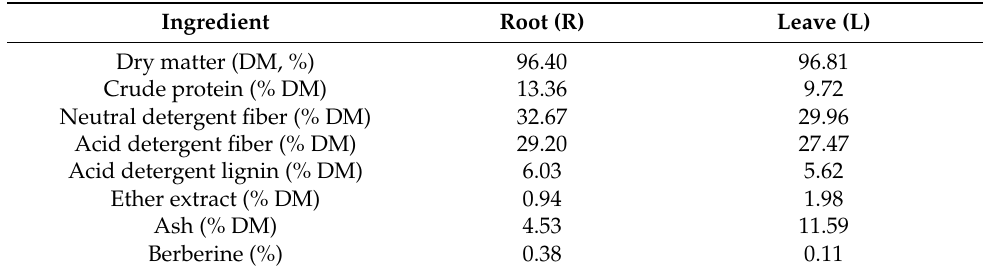
Table 1. Composition of goldenseal materials.